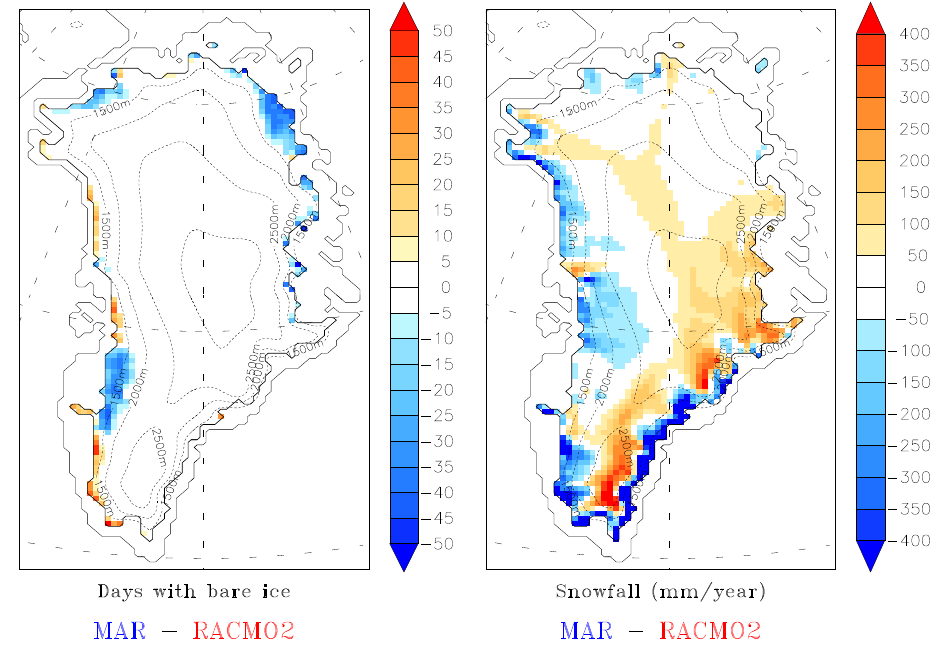
Fig. 7. Left – The mean difference of the number of days (per year) Fig. 7. Left – the mean difference in the number of days (per year) with bare ice at the surface simulated by MAR and by RACMO2. Right with bare ice at the surface simulated by MAR and by RACMO2. Right – The same but for the annual snowfall in mmWE. – the same but for the annual snowfall in